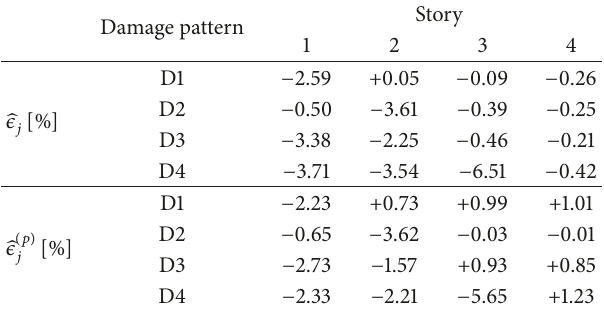
Table9:DamageindicesestimatedbySVD-basedprocedureincase of complete (on the left) and partial identification (on the right, by using only the first vector) on the shear-type frame.